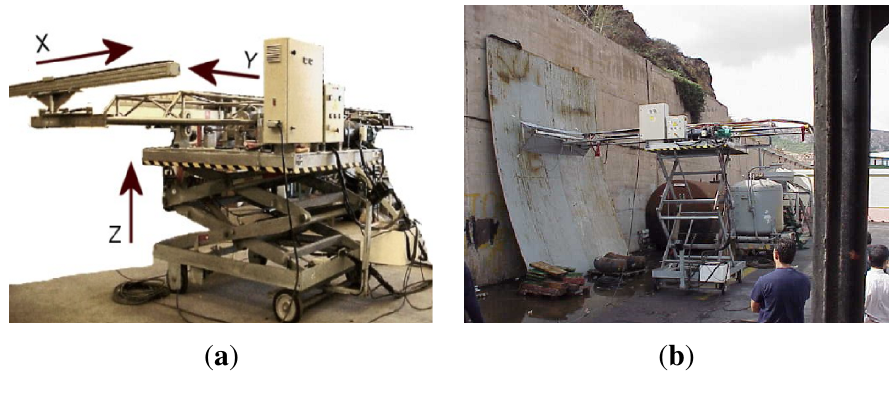
Figure 3. First approach to automatic of cleaning of ship